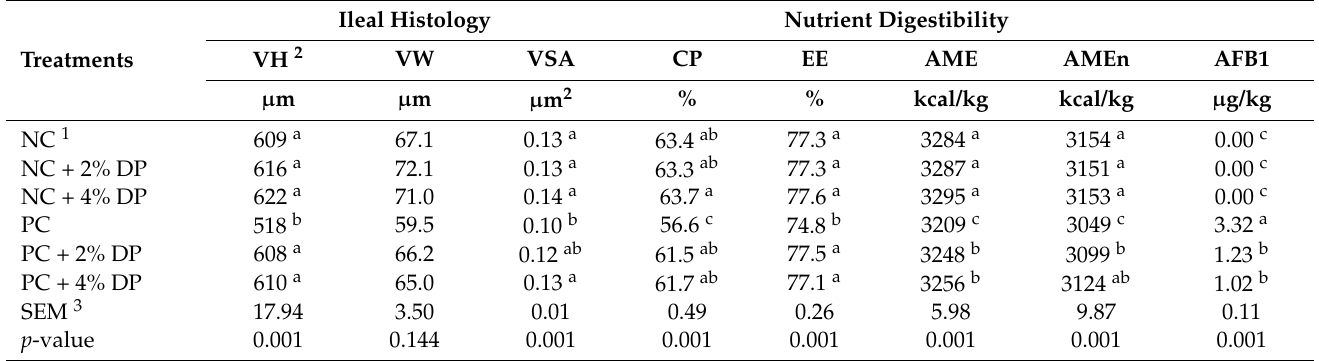
Table 5. Effect of adding two levels of date pits (DP) as aflatoxin adsorbent to aflatoxin B1 (AFB1)- contaminated diets on ileal histology, apparent nutrient digestibility, and residual AFB1 in the liver of